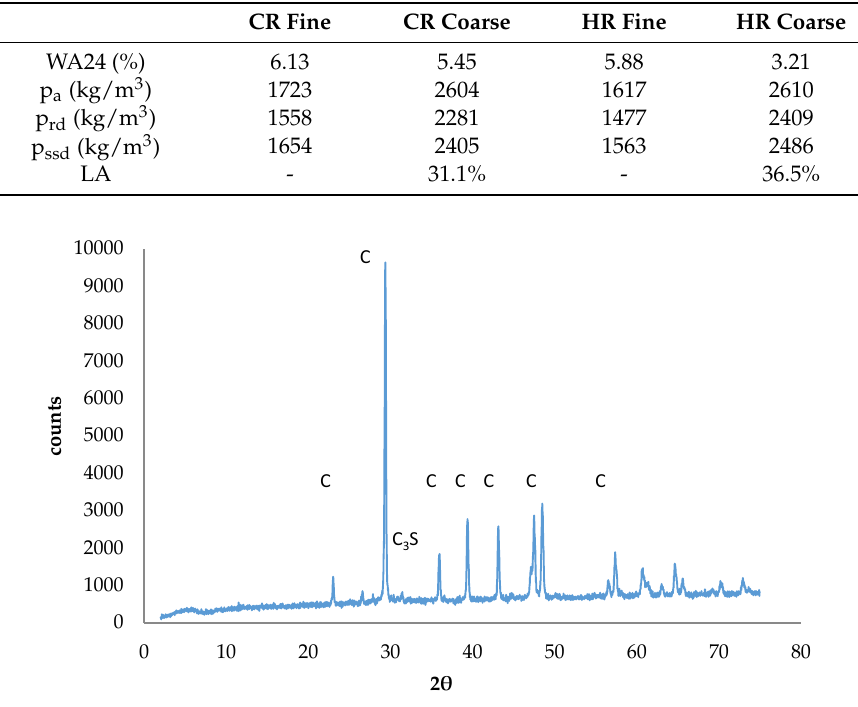
Figure 7. XRD diagram of CR, where C: calcite, Q: quartz and traces of C 3 S.